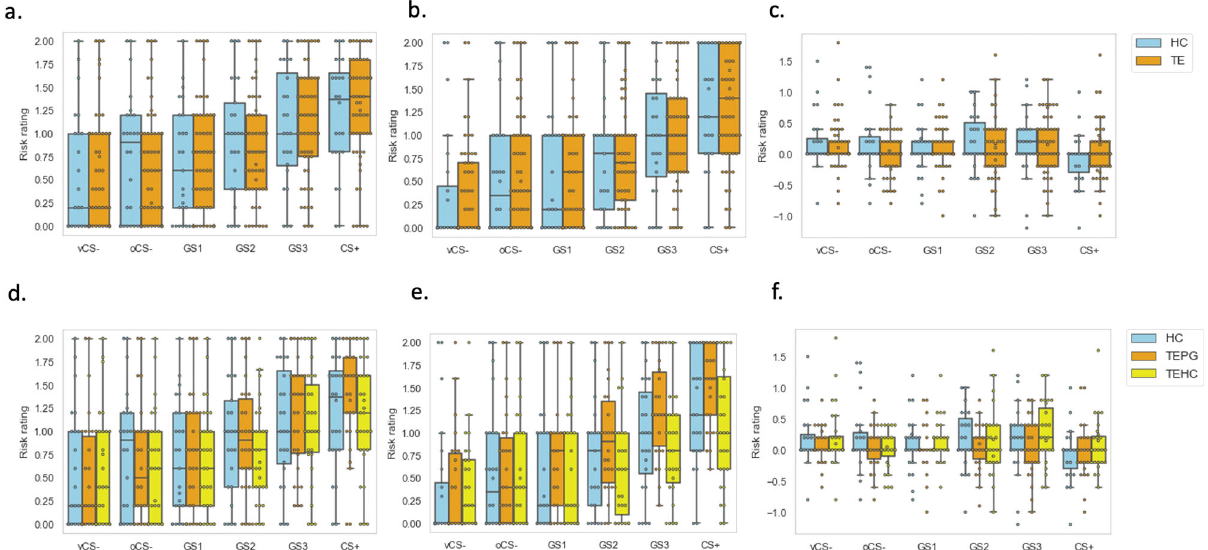
Fig. 1 Behavioral risk rating of the generalization task. a Risk rating in early generalization phase for TE and HC groups. b Risk rating in late generalization phase in TE and HC groups. c Risk rating of delta changes over time (EG-LG) in TE and HC groups. n = 88, error bar stand for ±2 standard error (SE). d Risk rating in early generalization phase in TEPG, TEHC and HC groups. e Risk rating in late generalization phase in TEPG, TEHC and HC groups. f Risk rating of delta changes over time (EG-LG) in TEPG, TEHC and HC groups. n = 88, error bar stand for ±2 standard error (SE). TE trauma-exposed participants, HC non-trauma-exposed healthy controls, TEHC trauma-exposed healthy controls, TEPG trauma-exposed psychopathology group, EG early generalization, LG late